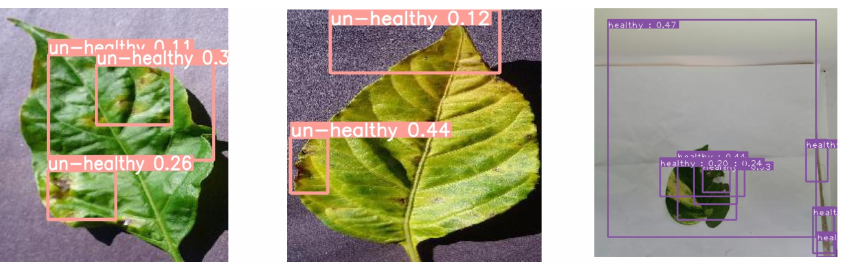
Figure 15. EfficentDET parameters.